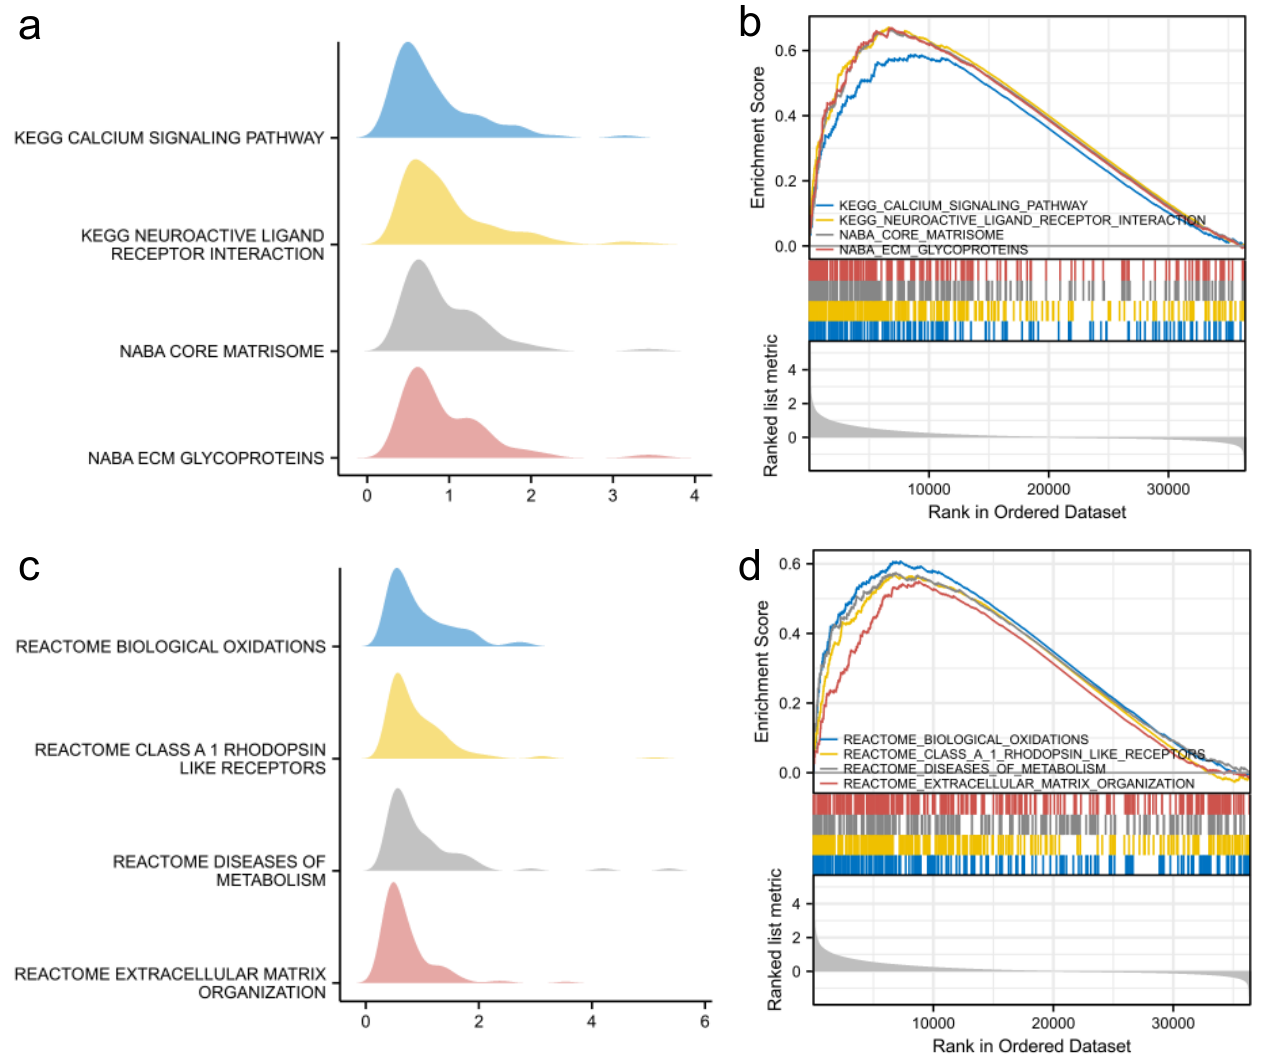
Figure 8. Enrichment plots of GSEA analysis. ( a – d ) Related eight main differentially enriched signaling pathways in SFRP1 high versus low samples.